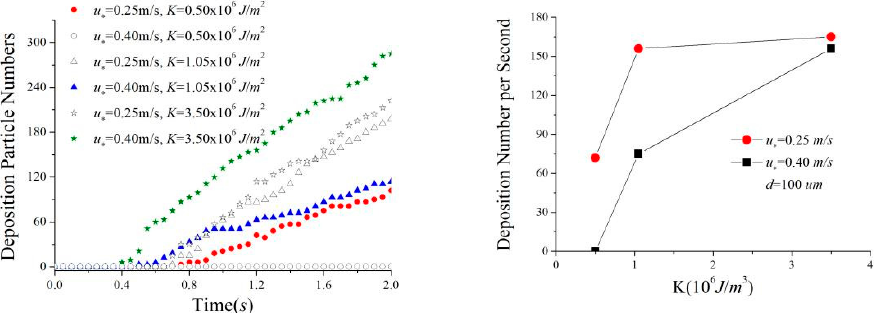
Figure 14. Comparison of the settlement amount and deposition rate of fine sand particles with different cohesion parameters and wind speeds. ( left ) Settlement amount. ( right ) Dust deposition rate.